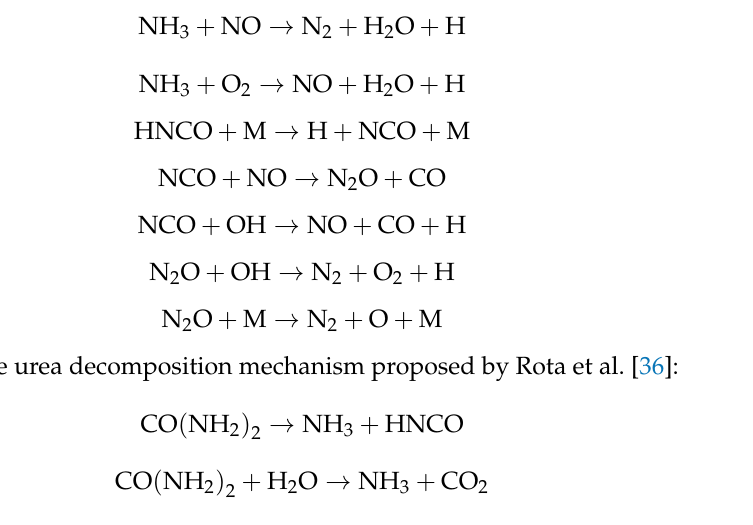
Table 6. Assumptions of the numerical